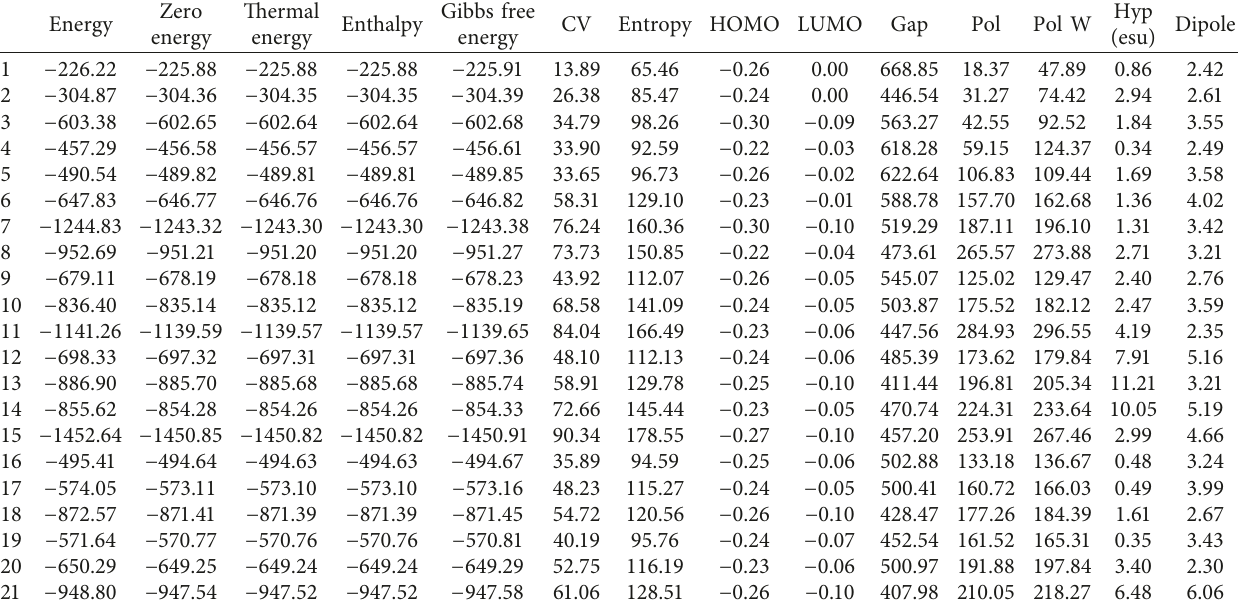
Table 4: The molecular properties of the modelled